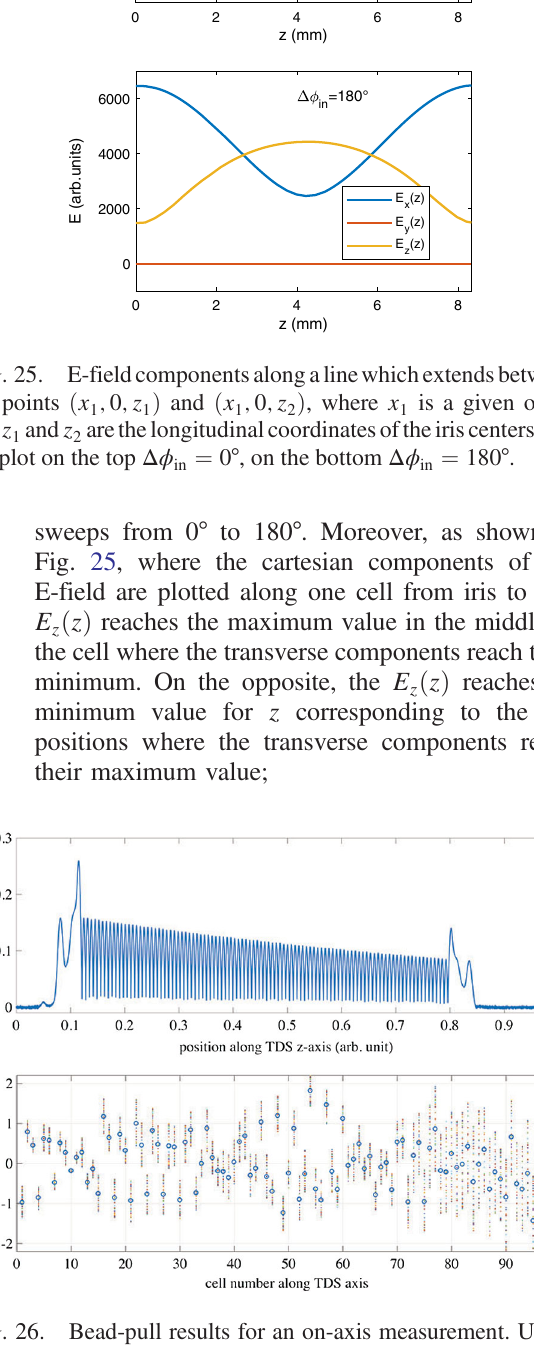
FIG. 26. Bead-pull results for an on-axis measurement. Upper plot: E-field pattern along the z -axis. Lower plot: cell-to-cell average phase advance deviations (blue circles) and phase advance deviations for different polarizations Δ ϕ 0 ° ; 10 ° ; … ; 360 ° (colored dots).